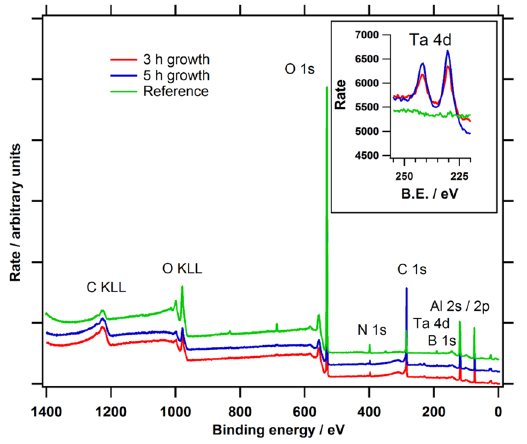
Figure 6. XPS wide scan spectra over a full wide energy range for two graphene samples grown for 3 h and 5 h and one reference sample. The inset is the Ta 4d high sensitivity spectra for the same three sample areas, showing the presence of Ta on all except the reference